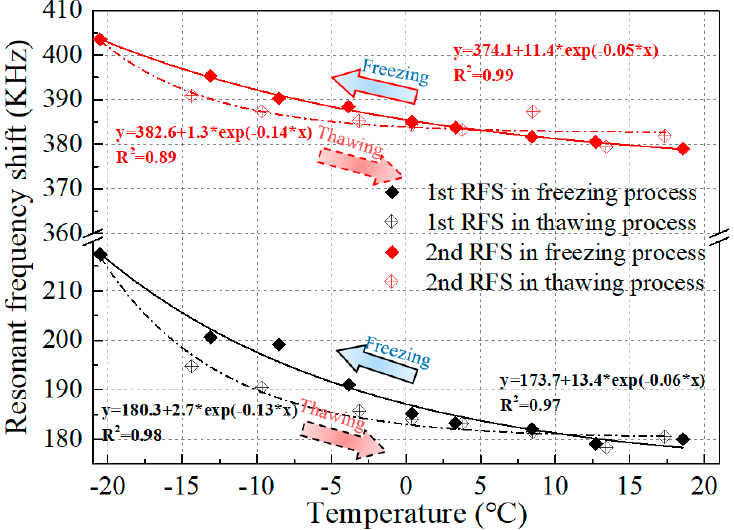
Figure 7. Resonant frequency shift (RFS) versus temperature.